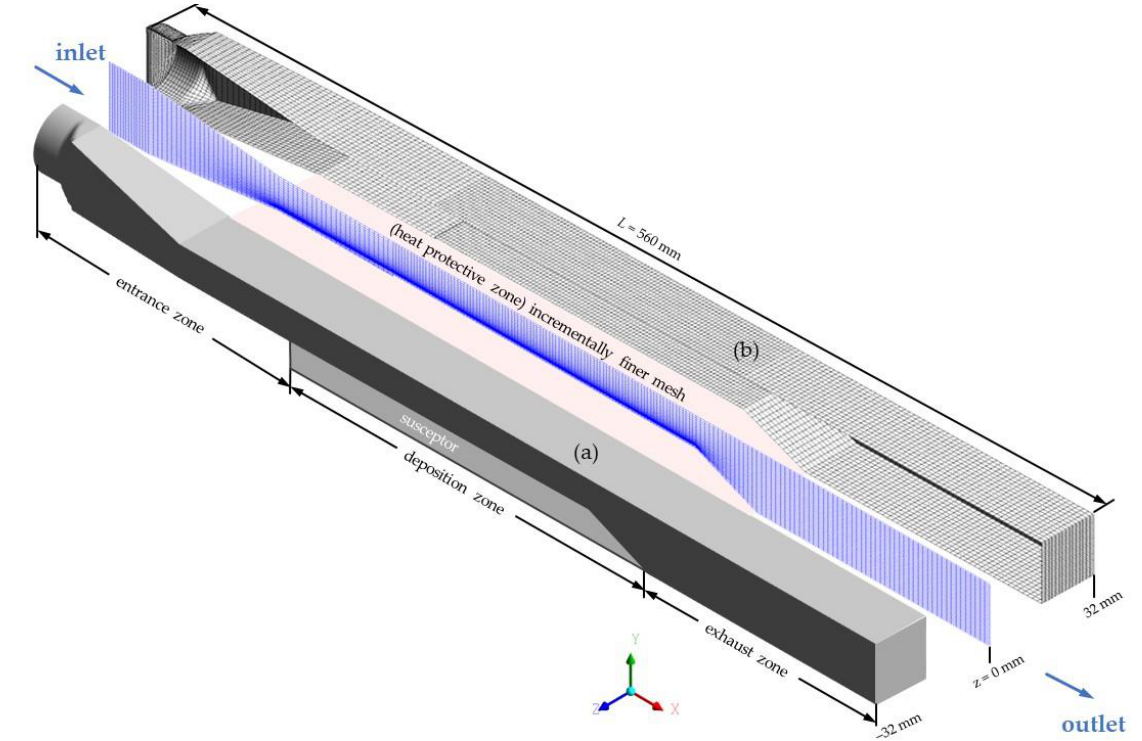
Figure 1. Scheme of ( a ) the horizontal MOCVD reactor geometry and ( b ) the structured hexahedral mesh of reactor (half view is shown for better clarity).